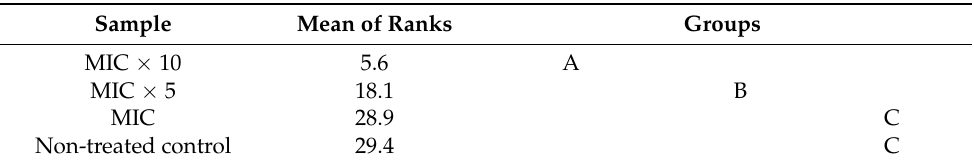
Table 5. Results of the Kruskal–Wallis test, followed by multiple pairwise comparisons using the Conover–Iman procedure for mean lengths of cankers in excised stems after inoculation with P. cacto- rum . The mean rank values accompanied by the same letters are not significantly different ( p -value (one-tailed) < 0.0001, α =